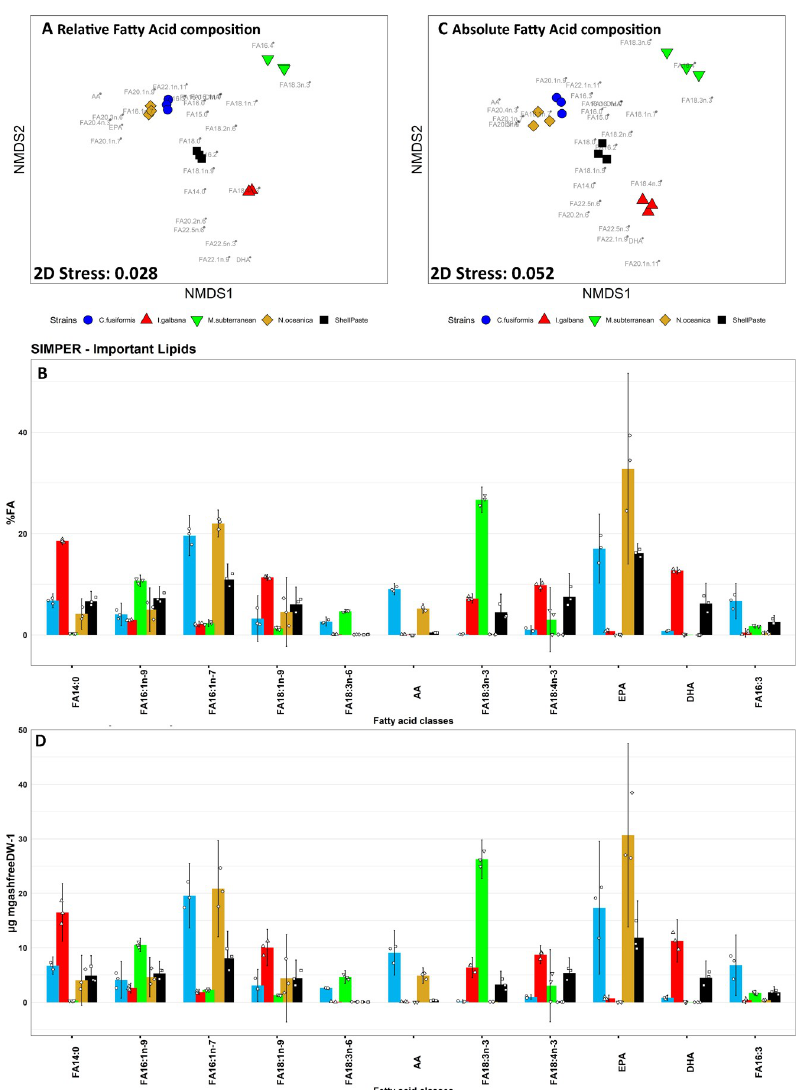
Fig 1. Non metric multidimensional scaling (nMDS) analisis and similarity percentages (SIMPER) analysis for relative (A-B) and absolute (C-D) fatty acid composition of diets. A: nMDS plot of the relative FA composition of diets (% total FA) provided during the feeding trial. Single FA loadings are stacked on the plot and reported in grey. B: principal variables explaining for a cumulative 75% of group differences in relative diet FA composition data evidenced by SIMPER analysis. C: nMDS plot of the absolute ( μ gFAmg DW-1 ) fatty acid composition of the diets. Single FA loadings are stacked on the plot and reported in grey. D: principal variables explaining for a cumulative 75% of group differences in absolute diet FA composition data evidenced by SIMPER analysis. Three replicates (n = 3) for each diet are here reported Charts B-D: data are reported as average (bar chart) ± 95% confidence interval; individual observations are jittered on the chart (smaller dots). Full data including all the FA observed and details on statistical significance values are found in S2 Table . essential PUFA (12.69 ± 0.24% /11.27 ± 1.57 μ gFA mg DW-1 ). AA and EPA were the most abun- dant PUFA in C . fusiformis and N . oceanica , with AA resulting higher in C . fusiformis than N . oceanica (respectively 9.05 ± 0.44% / 9.11 ± 1.66 μ gFA mg DW-1 and 5.20 ± 0.56%/4.90 ± 0.57 μ gFA -1 ) and with EPA showing the opposite trend (respectively 17.05 ± 2.74%/17.34 mg DW ± 4.91 μ gFA mg DW-1 and 32.79 ± 7.57%/30.67 ± 6.77 μ gFA mg DW-1 ). On the other hand, M . sub- terranean lacked in C20 PUFA and was characterised by large amounts of 18:3n-3 (26.63 ± 1.02%/26.28 ± 1.42 μ gFA mg DW-1 ).